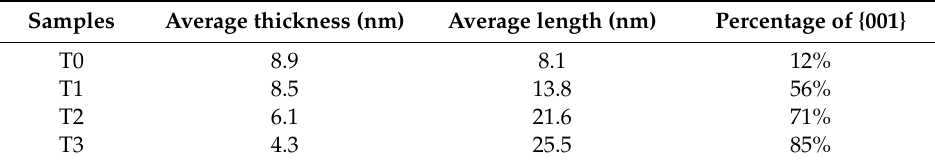
Figure 1. XRD patterns of different samples ( a ) without and ( b ) with nitrogen-doped quantum dots (NGQDs) decoration. (NGQDs) decoration. Table 1. Structural information of di ff erent anatase titania Table 1. Structural information of different anatase titania samples.